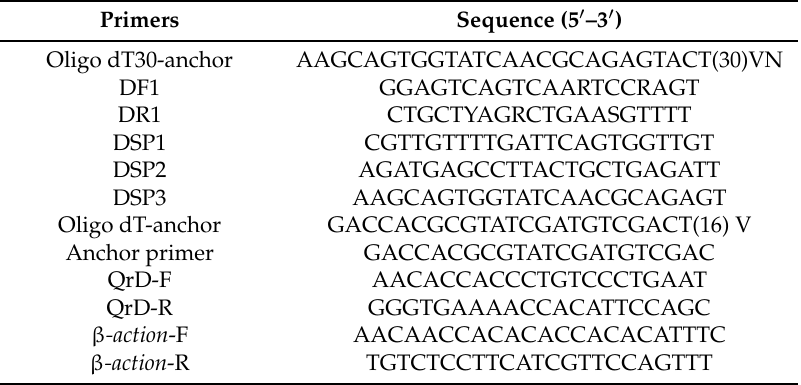
Table 1. Sequences of primers used in this